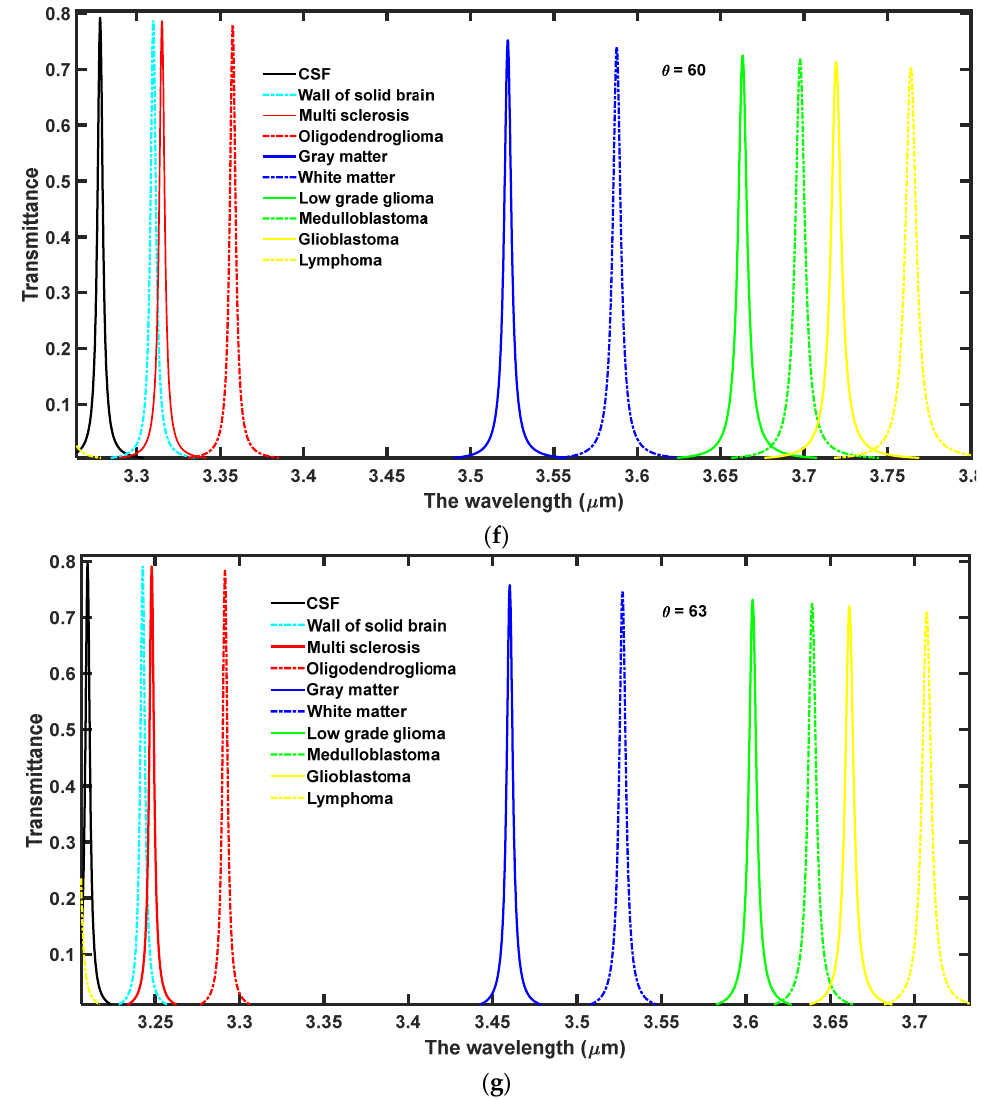
Figure 3. The transmittance spectra of 1D DPhC ( AB ) 2 CDC ( AB ) 2 infiltrated with ten different samples containing brain tissues with d 4 = 15 dd and η = 0.8 corresponding to oblique incidence at ( a ) θ = 10°, ( b ) θ = 20°, ( c ) θ = 30°, ( d ) θ = 40°, ( e ) θ = 50°, ( f ) θ = 60° and ( g ) θ = 63°.